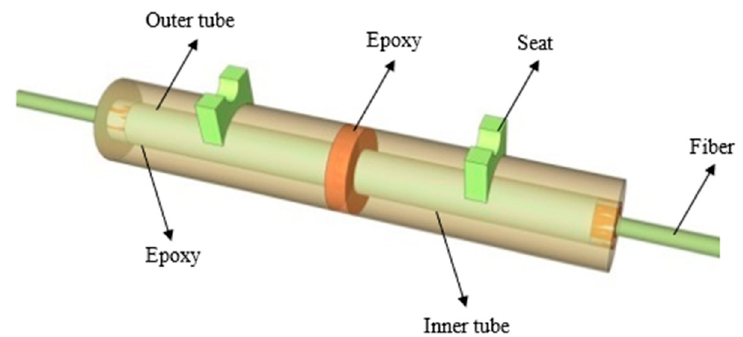
Figure 1. The schematic diagram of wide-range FBG strain sensor.